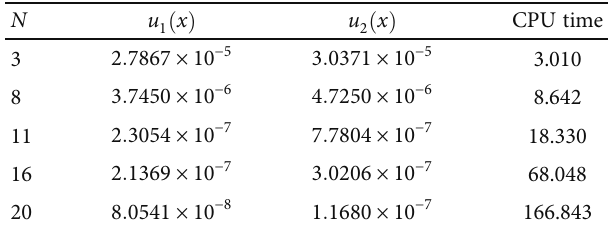
ð x Þ for N = 20 and ν = ν = 1 of Example 1. 2 1 2 Table 1: Maximum absolute errors for di ff erent values of N for Example